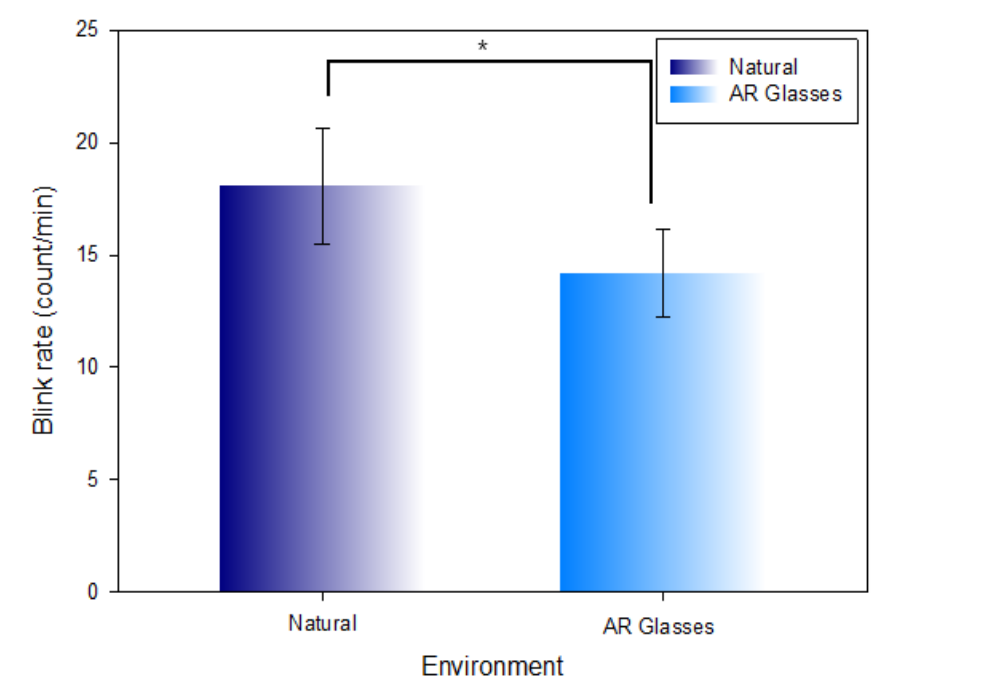
Figure 8. Comparison of the blink rate in the natural environment and AR glasses environment (*: p < 0.05).